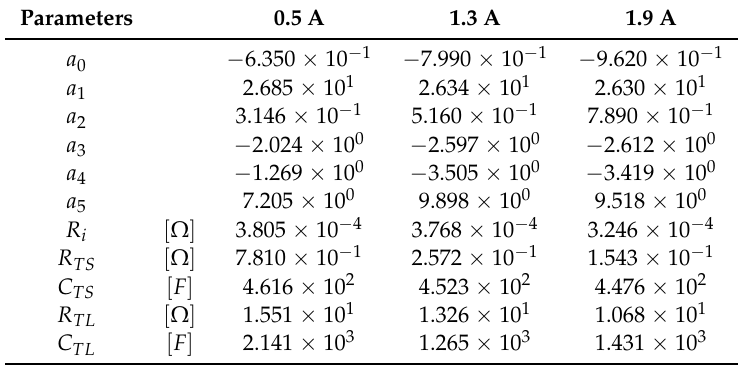
Table 2. The 11 parameters found versus discharge current for a 2.6 Ah Li-ion